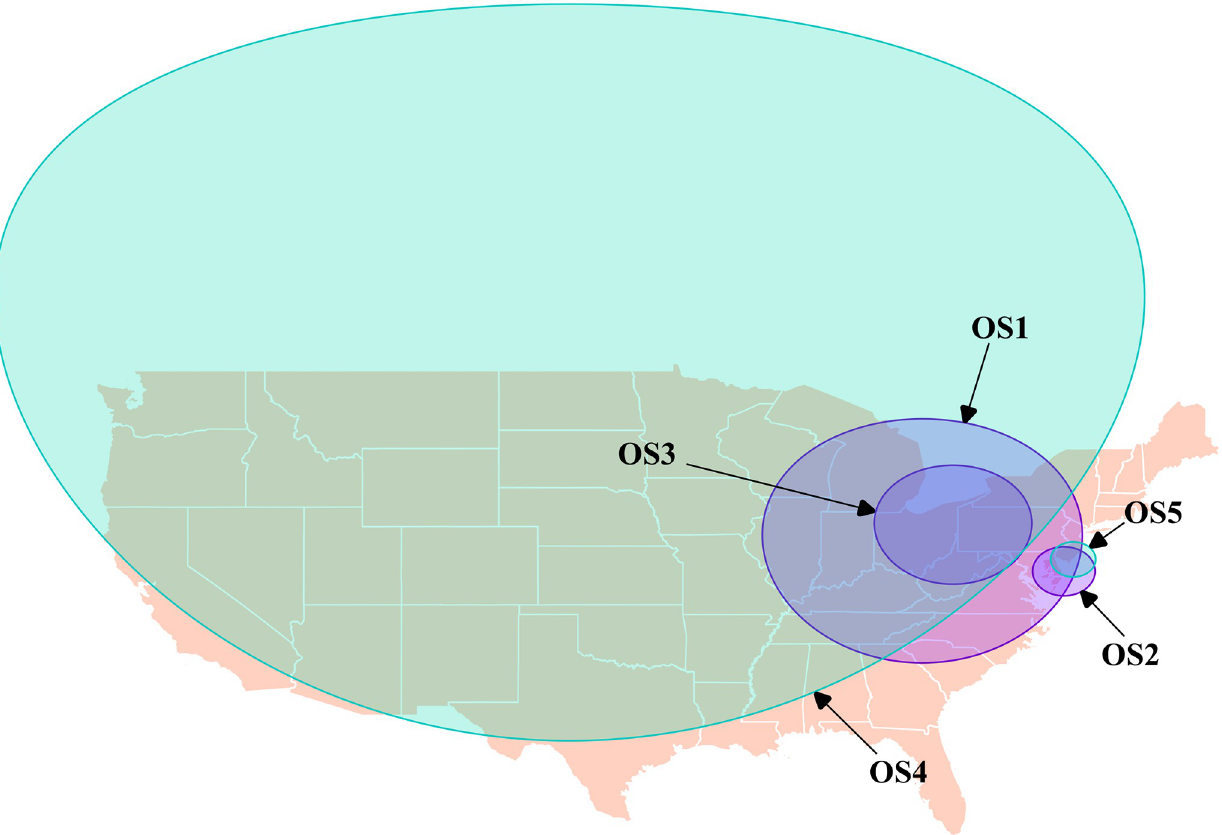
Fig 3. Locations of statistically significant spatial clusters identified with the spatial scan statistic using Bernoulli models, where there were statistically significant higher proportions of dog-associated poisoning calls to the Animal Poison Control Center related to opioids in the continental US